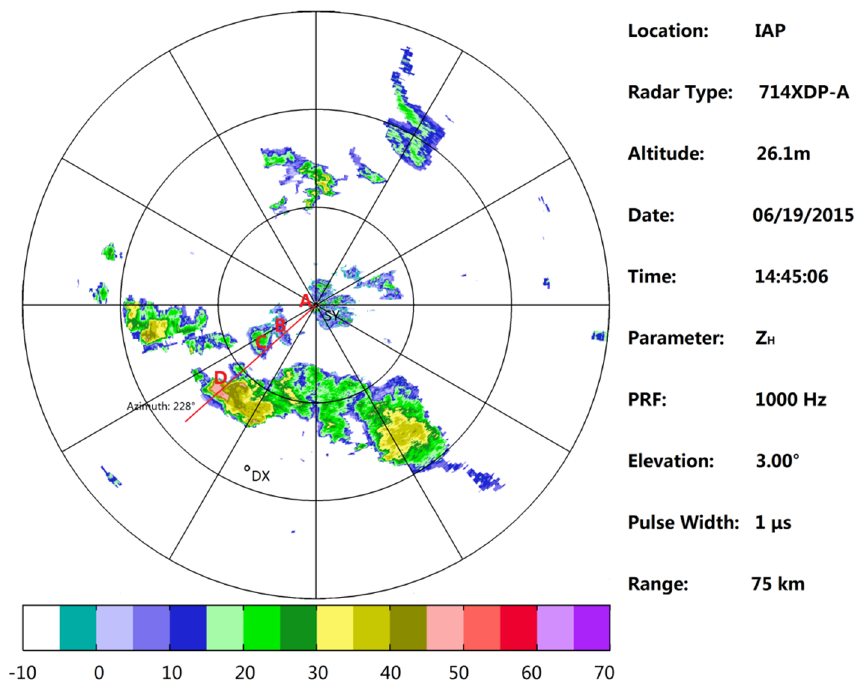
Figure 3. The reflectivity at X-band (elevation angle: 3°; range: 75 km) at 14:45 BJT, 19 June 2015.